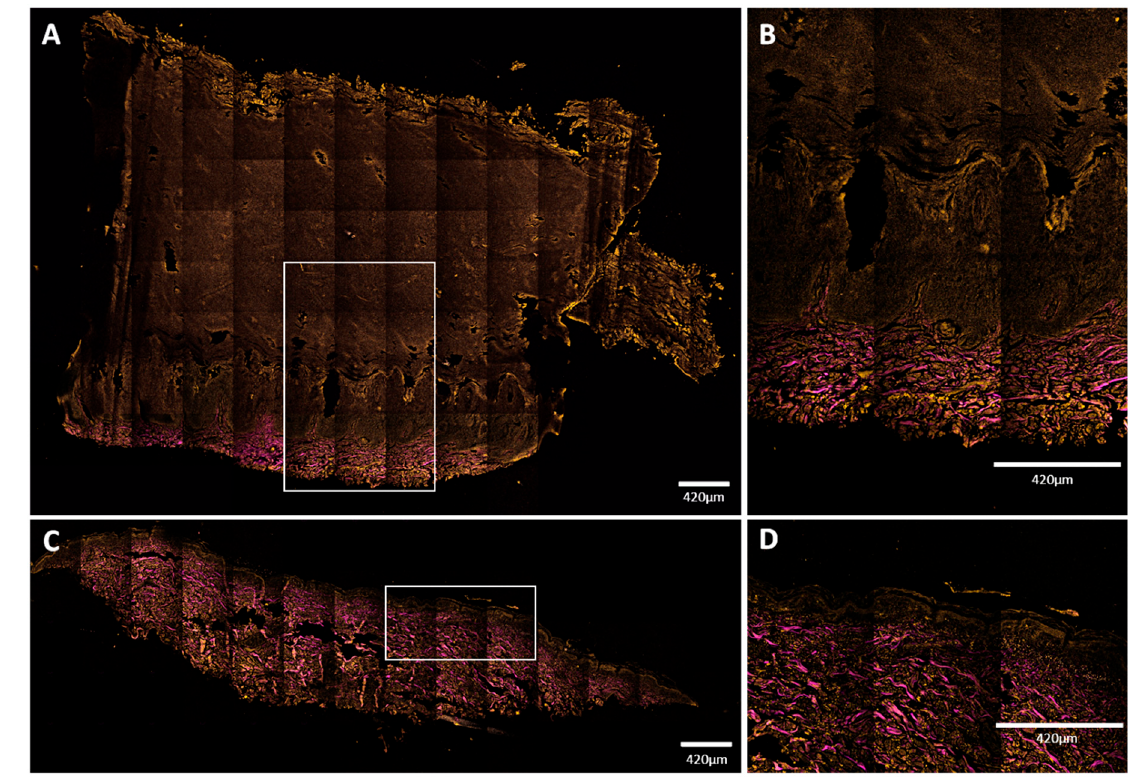
Figure 7. Mosaic NLM images of vertical skin sections. ( A , B ) Plantar keratoderma of the patient; ( C , D ) healthy control. Keratin had TPF signal in the orange channel, while collagen had SHG signal, indicated with magenta color. ( A , B ) Dermal papillae appeared in magenta; upwards, the basal keratinocyte layer can be seen in orange, followed by widened cellular layers of the epidermis and the increased amount of lamellar structure of the cornified keratinocytes. Total thickness of the epidermis was around 3000 μ m (range: 3079–3373 μ m). ( C , D ) The structure and proportion of the epidermis appeared to be as assumed in healthy subjects. Thickness of the epidermis was about 100 μ m (range: 96–146 μ m). Scale bar: 420 μ m. Pixel size: 0.1571 pixels/ μ m ( A , C ); 0.4012 pixels/ μ m ( B , D ).